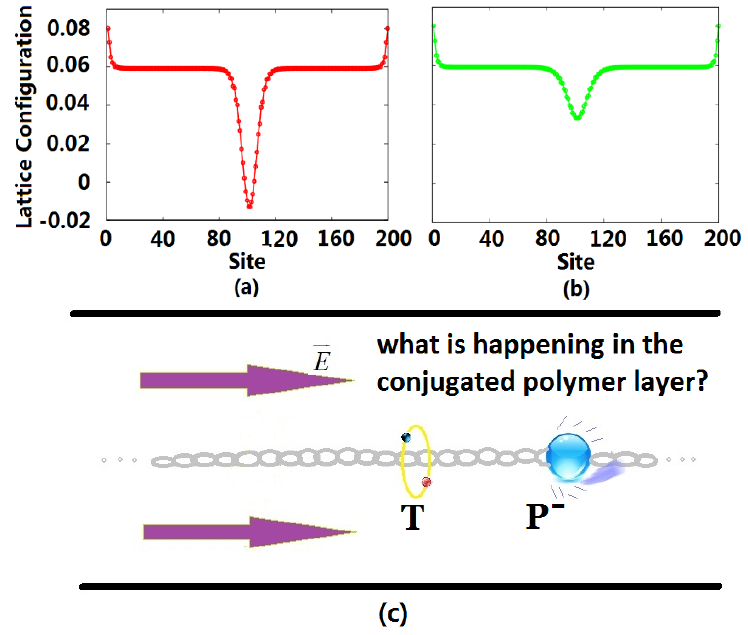
Figure 1. Lattice configuration of the triplet exciton ( a ) and negative polaron ( b ), where the unit of the vertical axis is Angstroms; and schematic graphic ( c ) of the collision of the negative polaron (P) and triplet exciton (T) inside the conjugated polymer layer. Initially, the triplet exciton stays in the middle of the polymer chain, and the polaron starts from the right side of the chain.